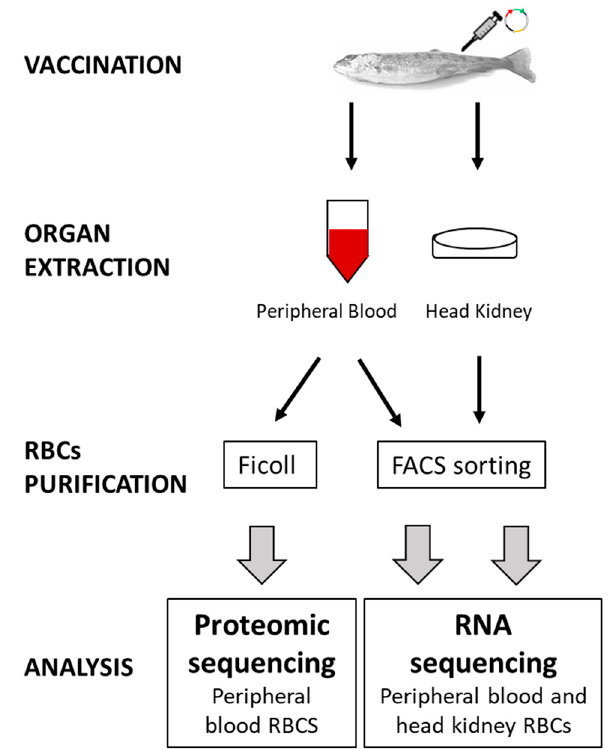
Figure 1. The general workflow of experimental steps from sample collection, 14 dpi, to data analysis.